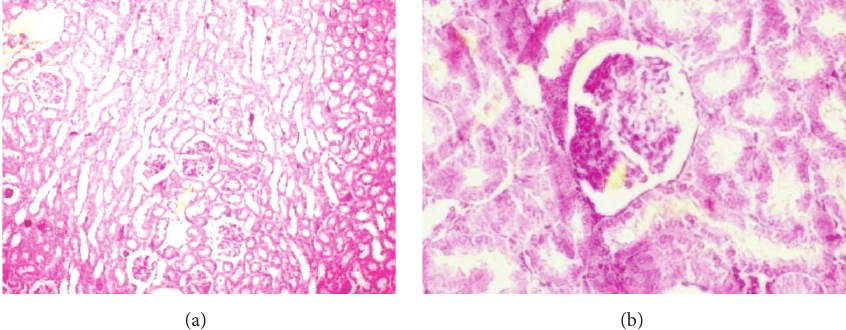
Figure 9: Histopathology of the kidney. (a) Histopathology of NC group kidney showed normal structure of the kidney. (b) The HF-DC group showed congestion of glomerulus, damaged tubules, inflammation, and cloudy degeneration in tubules.